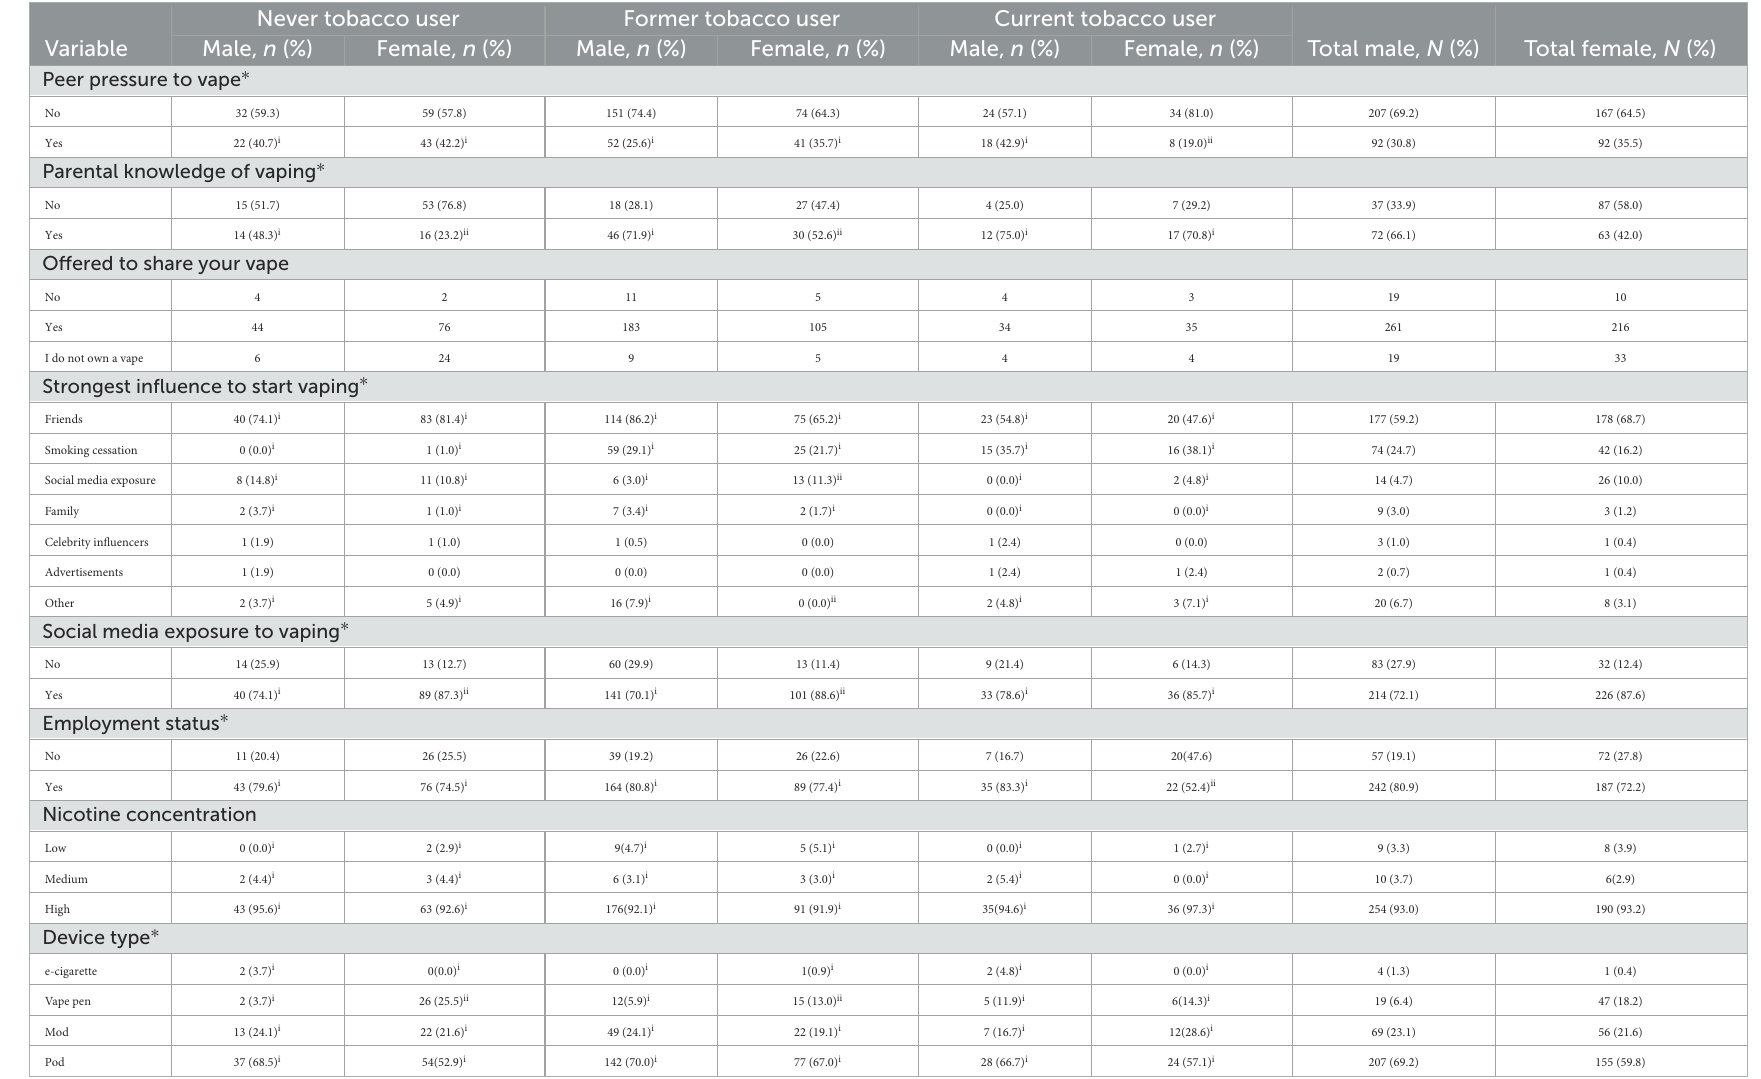
TABLE 2 ENDS user differences in social aspects organized by gender and tobacco use